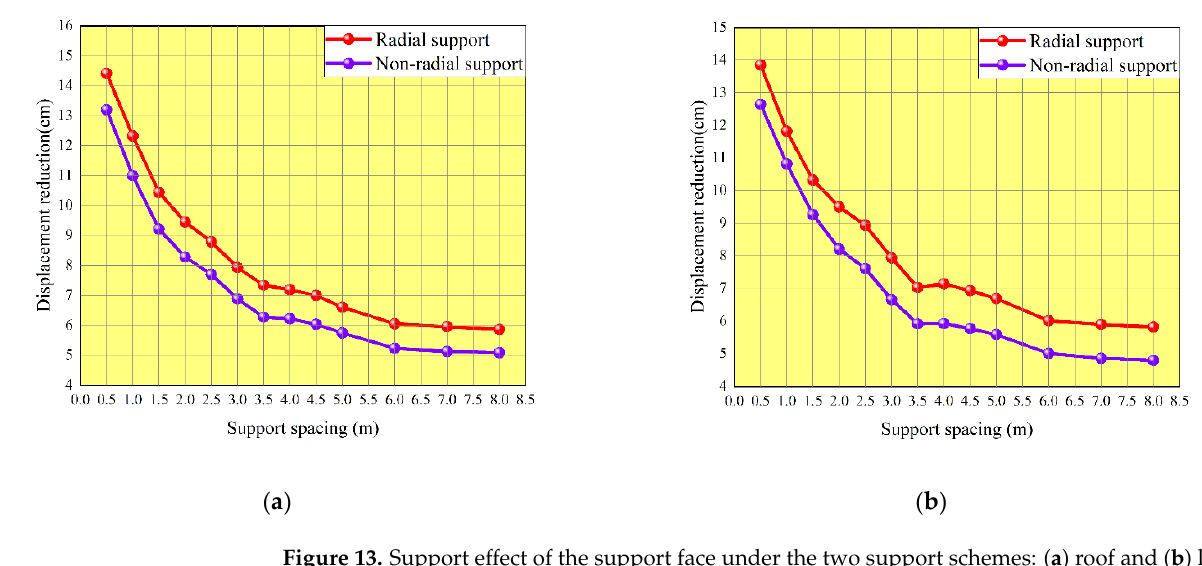
Figure 13. Support effect of the support face under the two support schemes: ( a ) roof and ( b ) lateral.